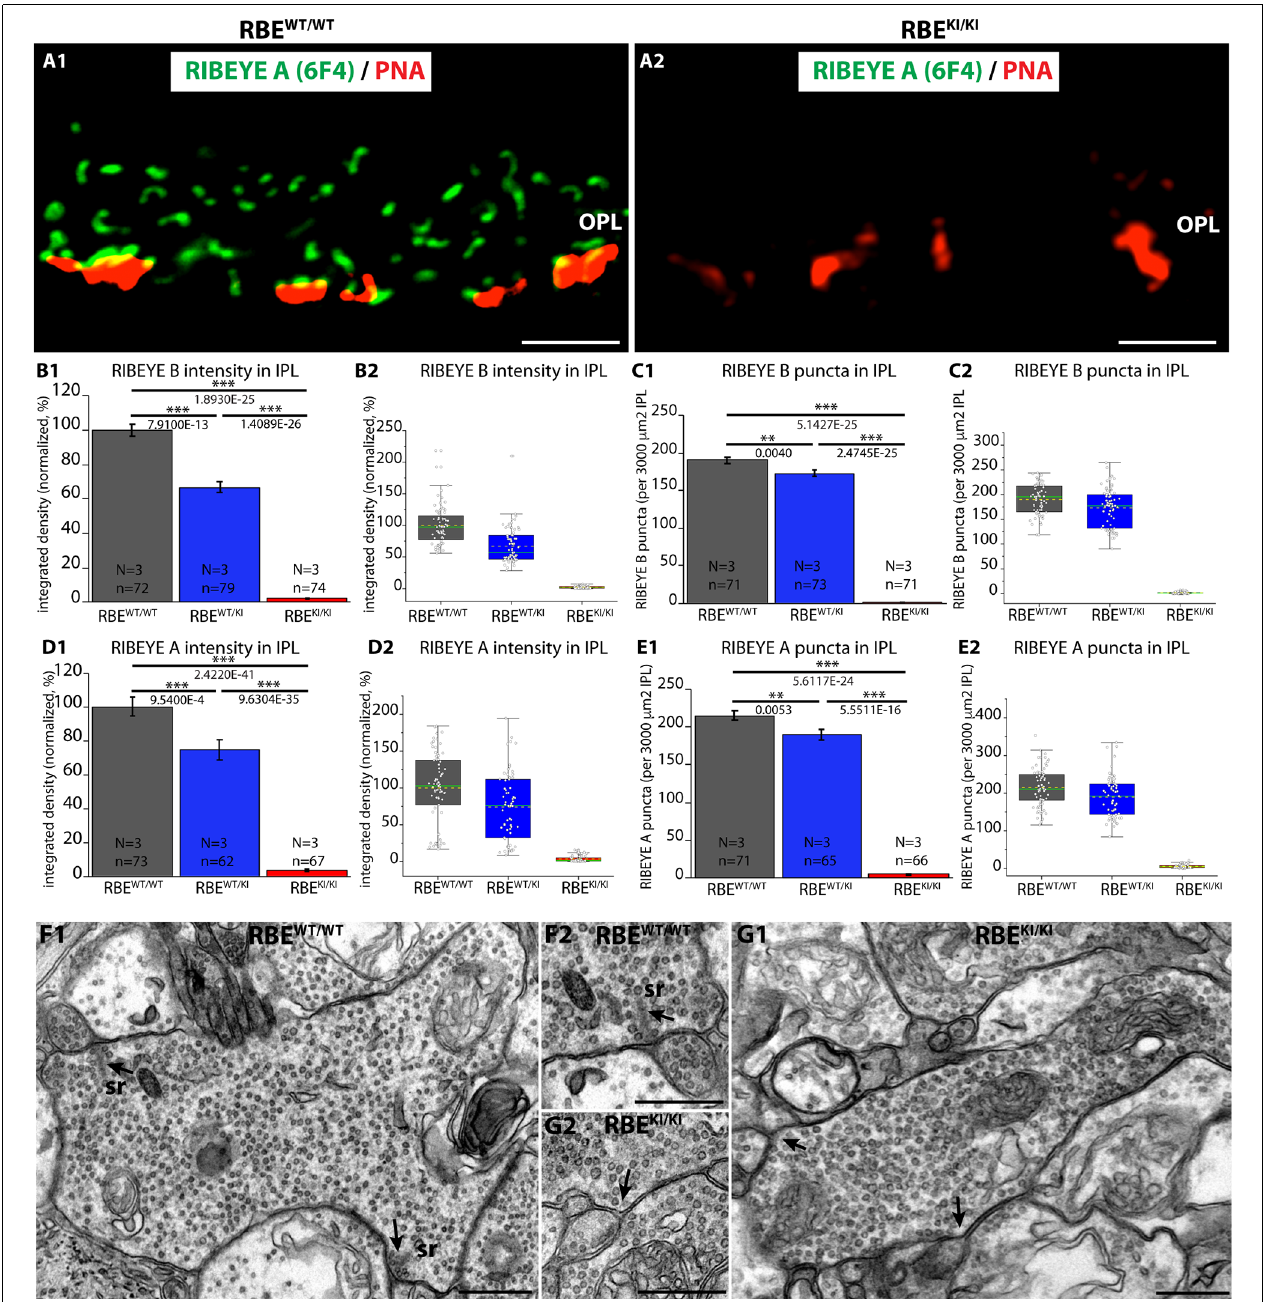
FIGURE 11 | Absence of ribbons in cone synapses of RBE KI/KI mice and quantification of RIBEYE immunosignals and RIBEYE puncta in the IPL of RBE WT/WT , RBE WT/KI , and RBE KI/KI mice. (A1,A2) Cryostat sections of retinas obtained from the indicated genotypes were stained with PNA lectin Alexa 568 to visualize cone synapses in the OPL and immunolabeled with anti-RIBEYE 6F4 to visualize ribbons. Despite the clear presence of PNA-positive cone terminals, no ribbons were present in the OPL of RBE KI/KI mice ( Figure 11A ). RBE WT/WT mice served as controls ( Figure 11A ). (B1,B2,C1,C2,D1,D2,E1,E2) RIBEYE(B)/RIBEYE A-domain immunosignals and RIBEYE(B)/RIBEYE A-domain puncta in the inner plexiform layer that was double-immunolabeled with antibodies against RIBEYE(B)/PSD95 ( Figures 2 , 3 ) and antibodies against RIBEYE(A)/SV2 ( Figures 4 , 6 ). (B1,B2,D1,D2) RIBEYE B-domain and RIBEYE A-domain immunosignals were completely absent in the IPL of RBE KI/KI mice. In RBE WT/KI mice, levels were inbetween the levels of RBE WT/WT and RBE KI/KI mice. (C1,C2,E1,E2) RIBEYE(B)/RIBEYE A-domain puncta were also completely absent in the IPL of RBE KI/KI mice. In RBE WT/KI mice, RIBEYE puncta (RIBEYE B-domain puncta and RIBEYE A-domain puncta) were between the levels of RBE WT/WT and RBE KI/KI mice. (C1) RIBEYE B-domain puncta in IPL: 190.1 ± 3.7 (mean ± S.E.M.) in RBE WT/WT , 172.9 ± 4.6 (mean ± S.E.M.) in RBE WT/KI and 1.5 ± 0.2 (mean ± S.E.M.) in RBE KI/KI mice. (E1) RIBEYE A-domain puncta in IPL: 215.0 ± 6.1 (mean ± S.E.M.) in RBE WT/WT , 189.5 ± 6.9 (mean ± S.E.M.) in RBE WT/KI and 5.5 ± 0.6 (mean ± S.E.M.) in RBE KI/KI . Values in (B1,C1,D1,E1) are means ± S.E.M. In the box and whiskers plot (B2,C2,D2,E2)